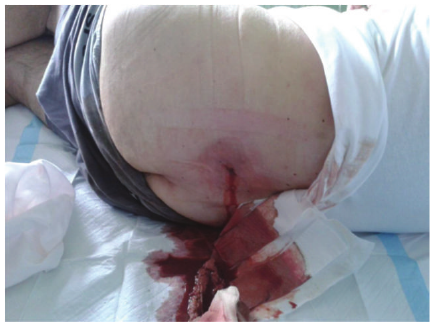
Figure 1: Image of left lumbar abscess drainage due to perforated diverticulitis.